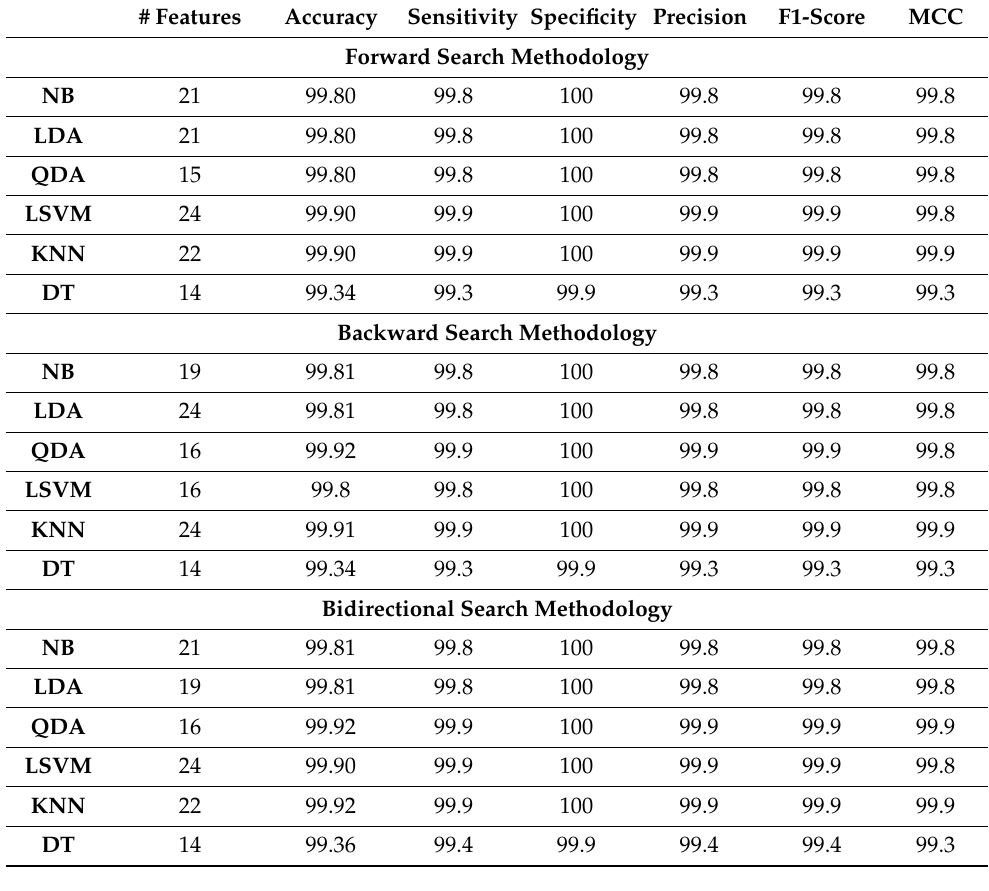
Table 4. A comparison between the results (%) obtained using each search strategy for each classifier and the number of features used in each methodology. # Features Accuracy Sensitivity Specificity Precision F1-Score MCC Forward Search